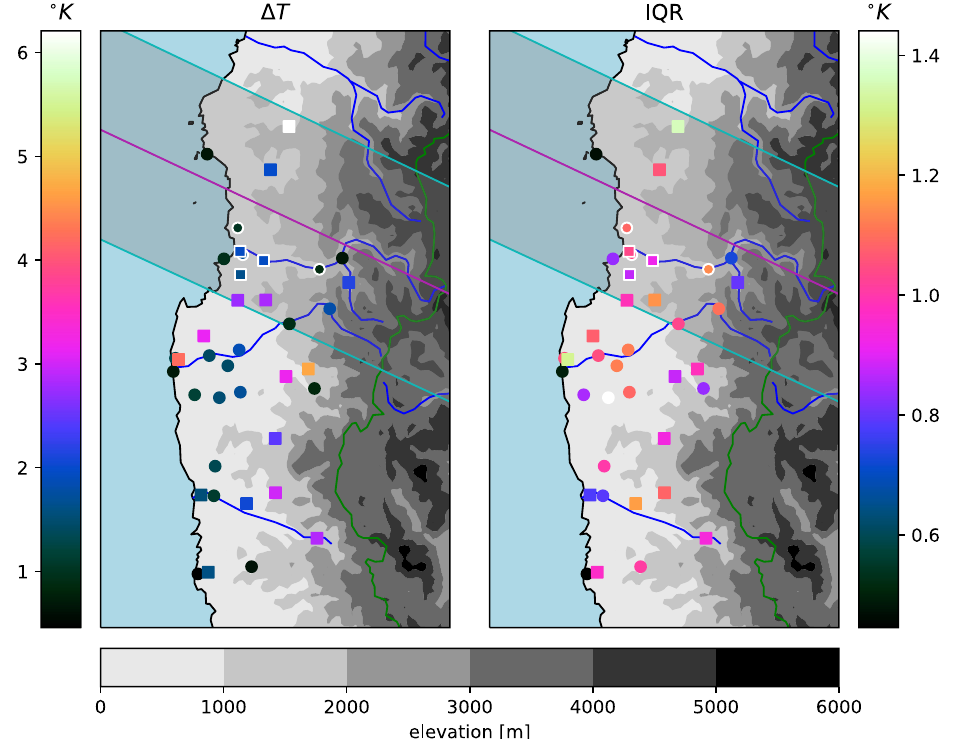
Figure 3. Estimated maximum 2m air temperature depressions ( (cid:31) T ) during the eclipse (left), based on the smoothing type lasso regression, and IQR of the estimates (right). The lasso estimates for (cid:31) T are corrected for the bias of the error distribution. Square symbols mark estimates which fall outside 95% of the test error distribution for a given station, and white marker edges correspond to the stations shown in Figs. 1 and 2. Cyan lines demarcate the edges of the band of totality and the magenta line its center 61 . Gray shading indicates terrain elevation 62